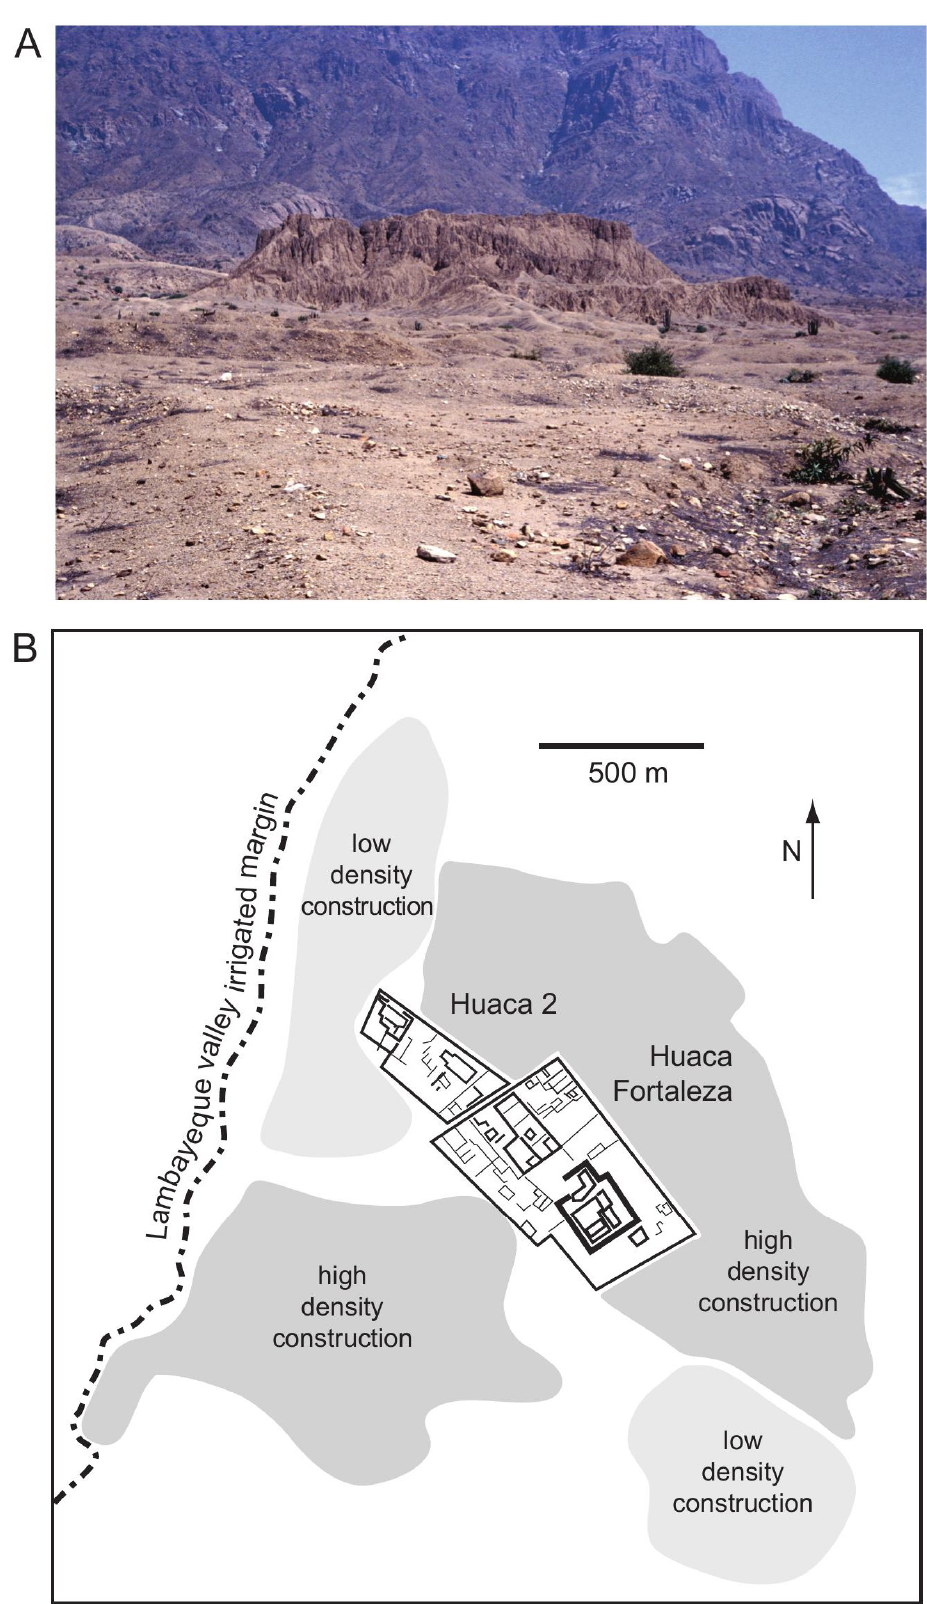
Figure 2. Pampa Grande site. ( A ) Photo of the Huaca Fortaleza, the largest mound at the site. (Photo by Daniel H. Sandweiss) ( B ) Schematic map of the Pampa Grande site. (Map adapted by Kirk A. Maasch from [24]: Figure 1).